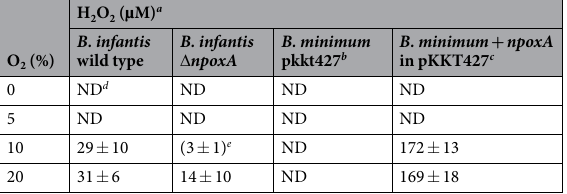
NADPH oxidase activity were collected and purified by additional column chromatography steps. At each purification step, only one predominant active elution peak was detected. After the final step of affinity chromatography, the purified fractions appeared as a single band (29 kDa) by SDS-PAGE (Fig. 2B). The N-terminal sequence of the purified NADPH oxidase (NPOX) was sequenced, and the amino acid sequence (MVTNATIEALLGRRSIRKFK) showed 100% identity with the N-terminal sequence of the Blon_2447 gene product of B. infantis ATCC15697 in the genome database.